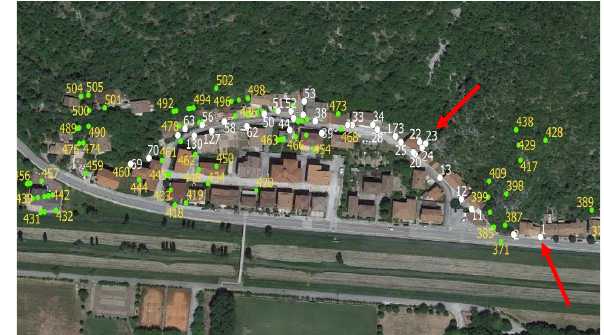
Figure 6. Deformation velocity map (processing period 2014- 2021) with corresponding legend with 5 ranges of terrain displacement values expressed in millimetres.